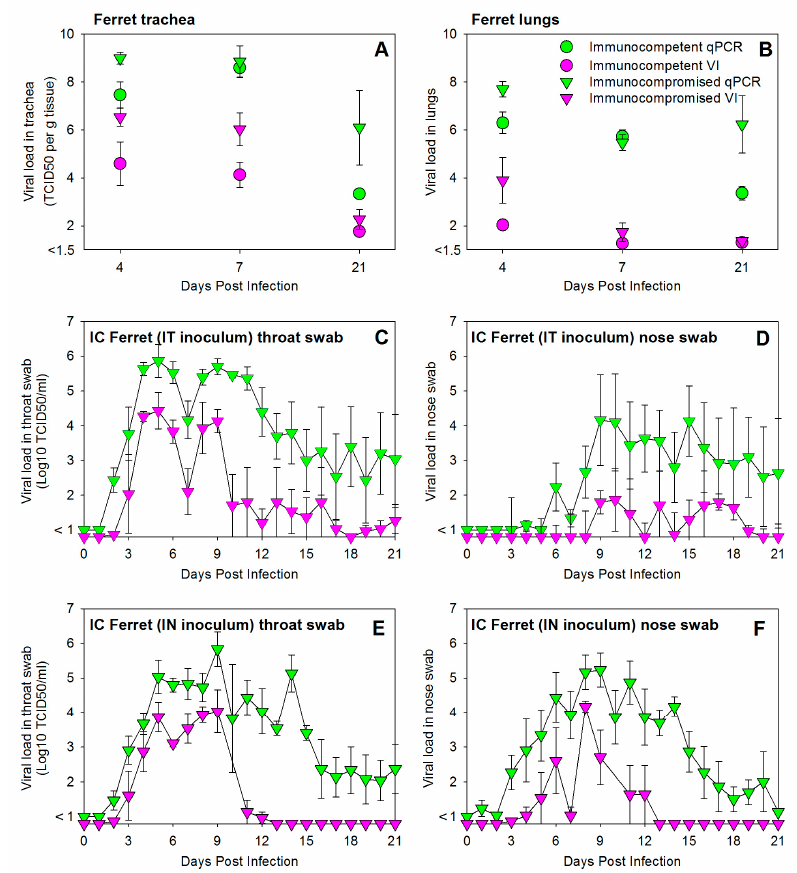
Figure 2. Experimental infection of immunocompromised ferrets with a low-passage wild-type HRSV subgroup A strain results in higher and prolonged virus replication in both the upper and lower respiratory tract. HRSV loads in trachea ( A ) or lungs ( B ) were detected by qPCR and virus isolation after necropsies at 4, 7, or 21 DPI. HRSV loads in throat swab ( C , E ) or nose swab ( D , F ) samples collected daily from immunocompromised ferrets infected by IT ( C , D ) or IN ( E , F ) inoculation (group numbers #4 and #9, respectively). All data are presented as geometric means ± standard error of the mean of groups of three animals (Table 1). Immunocompetent and immunocompromised ferrets are shown by circular and triangle-shaped symbols, respectively; qPCR and virus isolation data by green and purple symbols, respectively. Viral loads are shown in TCID 50 equivalents per gram tissue ( A , B ) or TCID 50 per mL ( C – F ).